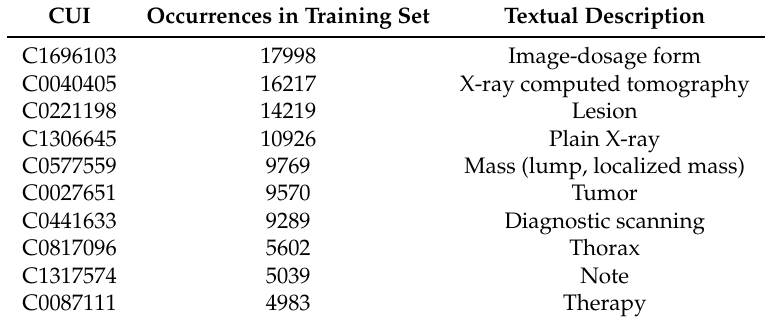
Figure 5. A few samples from the ImageCLEF 2017 concept detection data set with their respective file IDs and trimmed list of concept identifiers. Table 3. The ten most frequently occurring concepts in the ImageCLEF 2017 training set for concept detection.